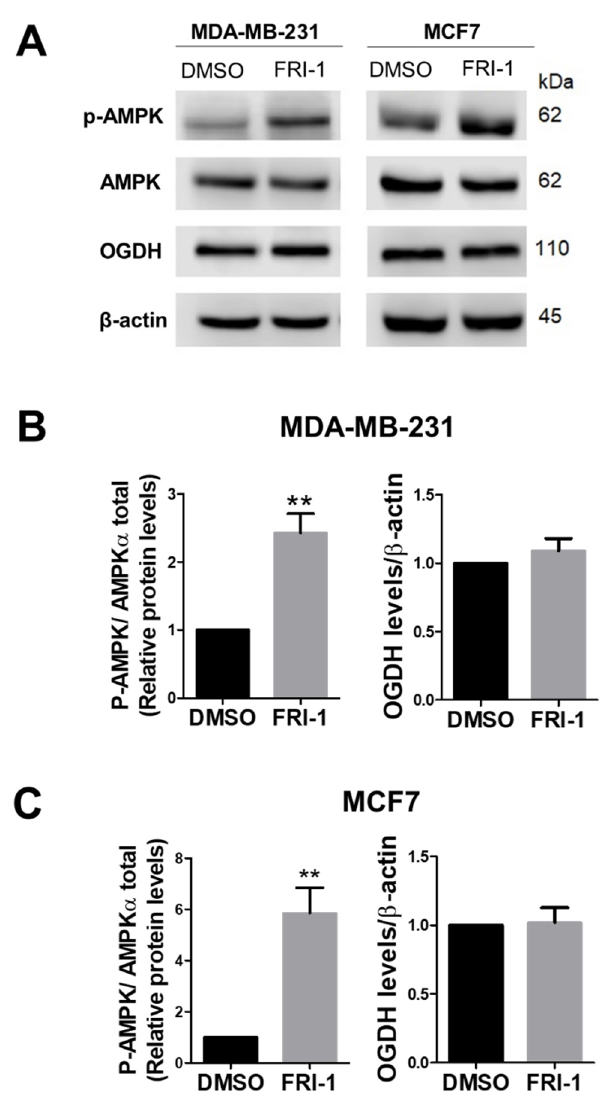
Figure 7. FRI-1 induces AMPK phosphorylation without changes in 2-oxoglutarate dehydrogenase (OGDH) levels in BC cells. ( A ) Representative figure of the effect of FRI-1 on phospho- and total- AMPK and OGDH levels at 4 h of treatment; ( B ) Quantification for MDA-MB-231 and ( C ) MCF7 cells. The data shown are the mean ± SD of three independent experiments. ** p < 0.01 vs. control (DMSO).